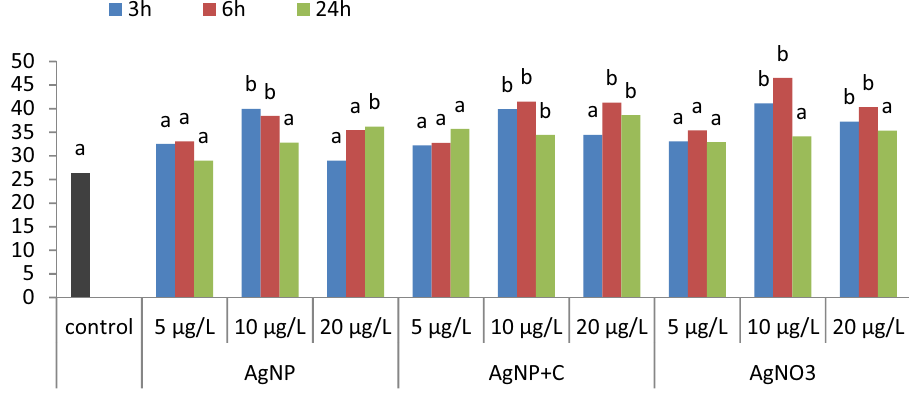
Figure 1. The mean percent content of DNA in the comet tail for the control samples and the cells tested at various concentrations, after 3, 6 and 24